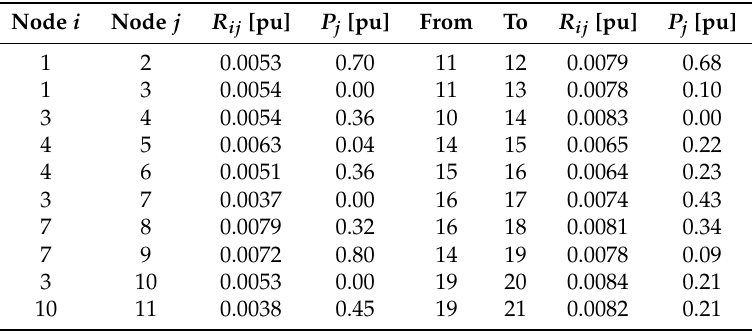
Table 1. Parametric information of the 21-node test system.